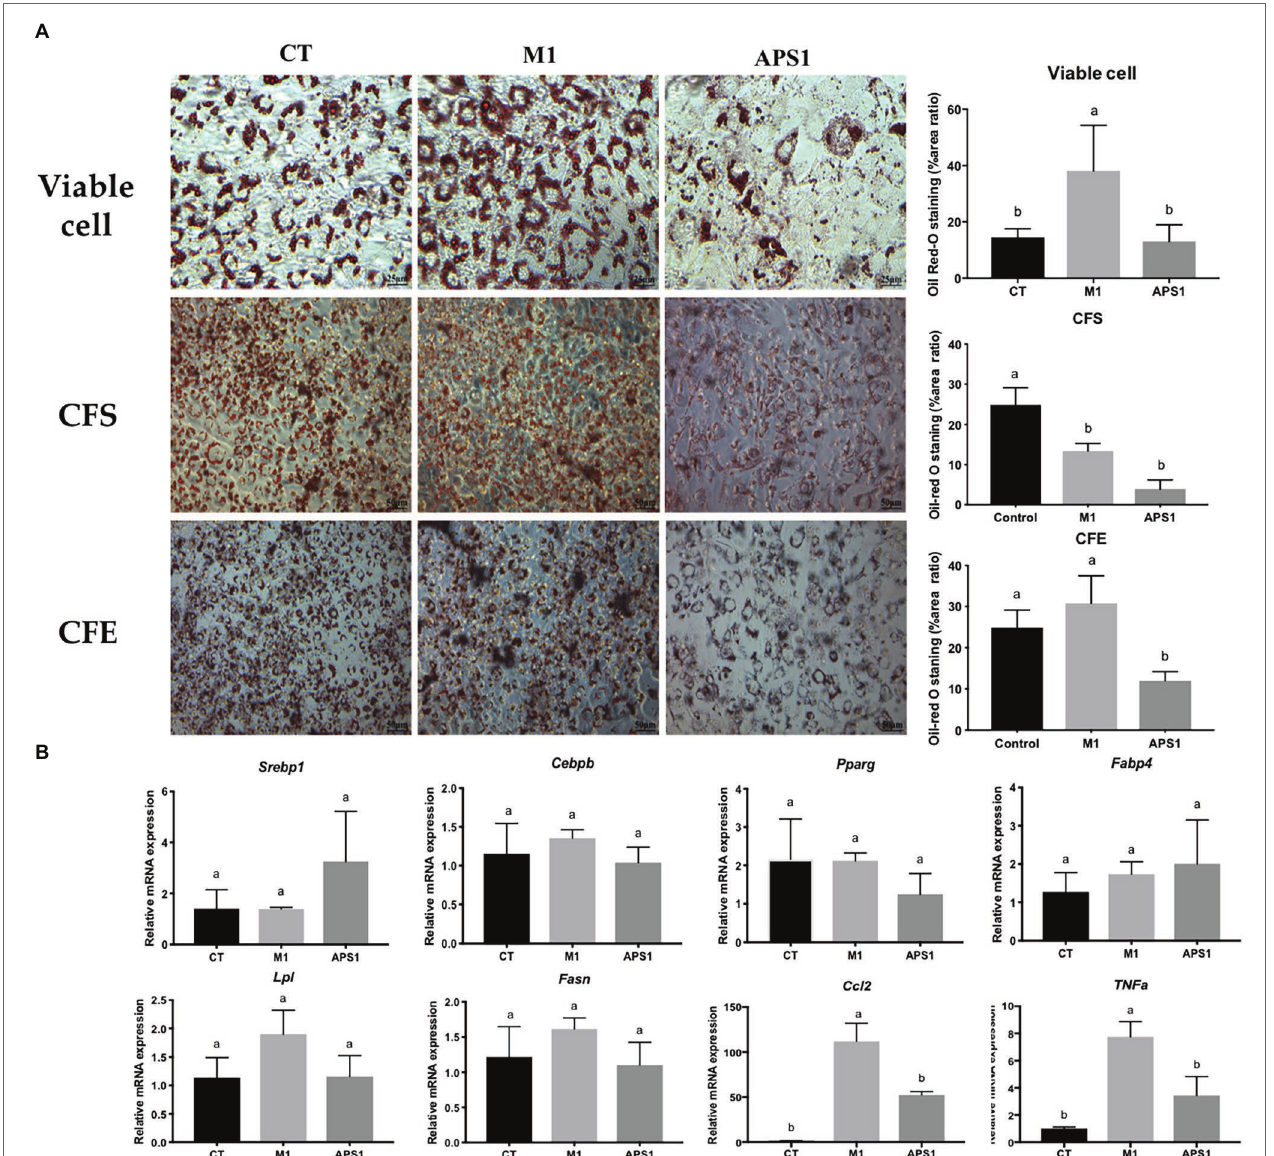
FIGURE 1 | Effects of M1 and APS1 on modulation of adipogenesis in 3T3-L1 cells. (A) Lipid accumulation and the area ratio by ImageJ (%) in 3T3-L1 cells treated by viable cell, intracellular cell-free extract (CFE), bacterial cell-free excretory supernatant (CFS) of M1 and APS1 with Oil red O staining; and (B) modulation of adipogenesis and macrophage-derived Tnf and Ccl2 relative mRNA levels in 3T3-L1 adipocytes after treated with viable M1 and APS1. Relative quantification of gene expressions was performed using the comparative Ct method with normalization to glyceraldehyde-3-phosphate dehydrogenase (GAPDH). Results were expressed as fold difference relative to a relevant control sample. Data are expressed as the mean ± SD ( n = 3). Labeled means without a common superscript letter differ, p <